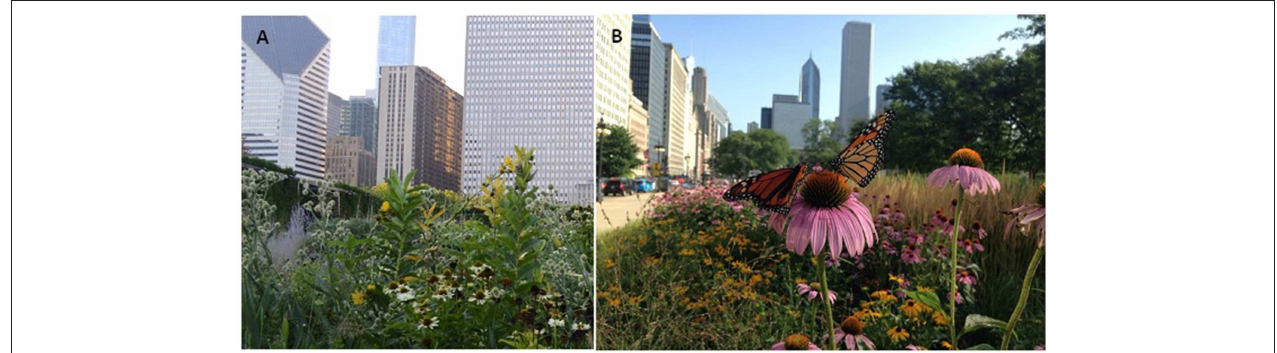
FIGURE 2 | Analysis extent of four metropolitan areas: Chicago, Minneapolis-Saint Paul, Kansas City, and Austin, where field research was conducted to study ecological and social factors related to monarch butterfly habitat in urban/suburban areas. Shaded areas represent urbanized areas (US Census) within the metropolitan analysis extent (heavy outlined boundaries). Metro-transect lines shown in blue run from densely populated urban centers to rural sparsely populated areas. Evenly spaced sampling points (red) show where field teams were directed for sampling.